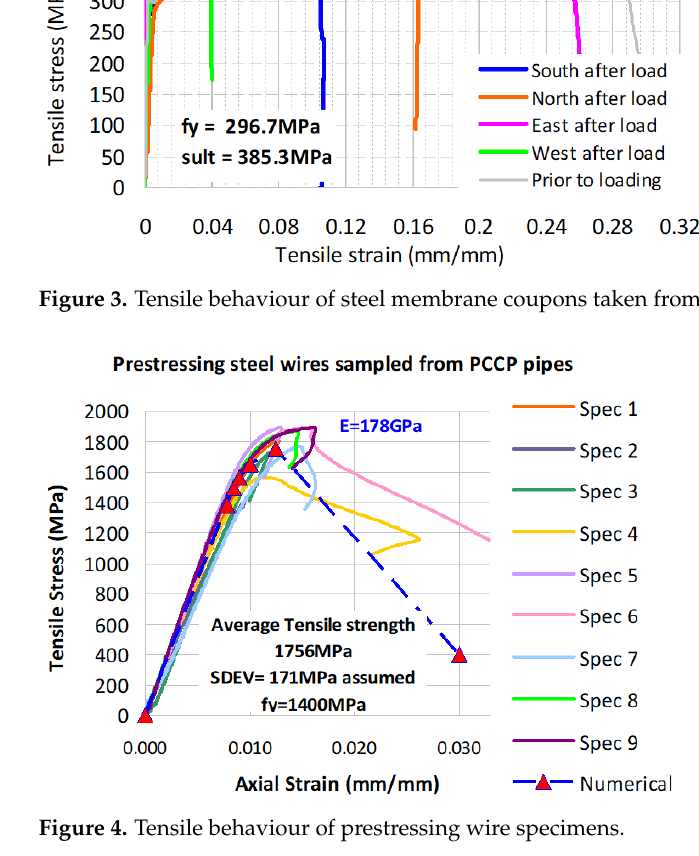
Figure 4. Tensile behaviour of prestressing wire specimens.